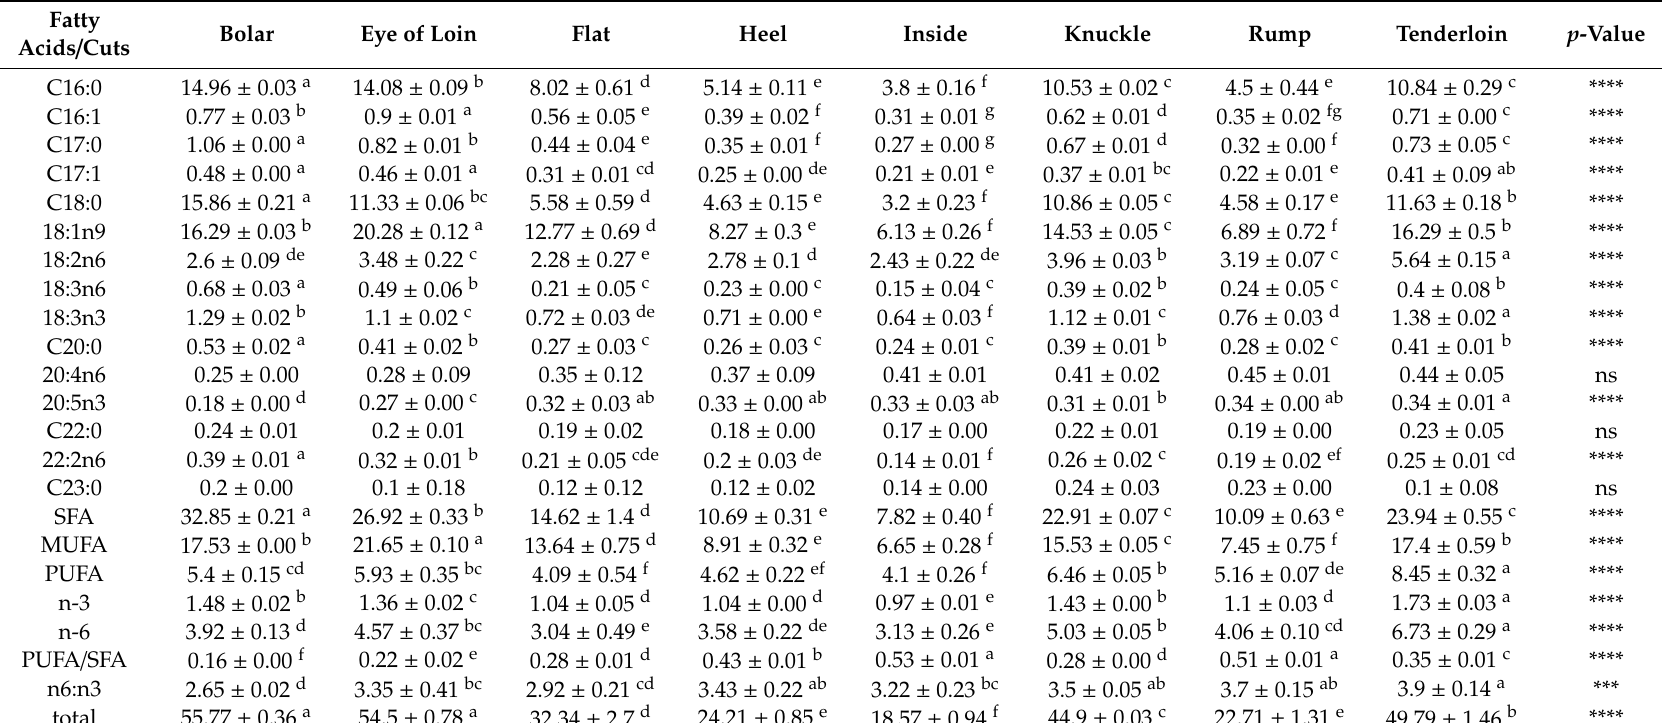
Table 1. Fatty acid composition (mg / 100g) in di ff erent New Zealand lamb meat